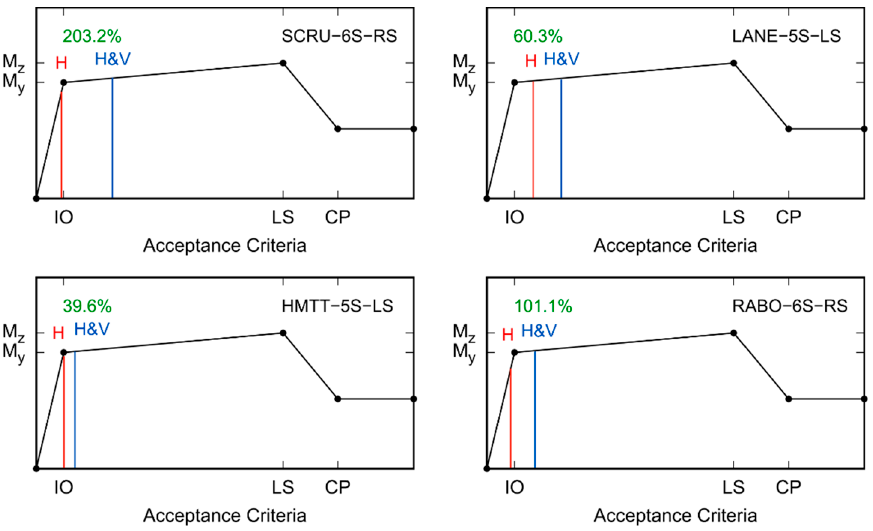
Figure 16. Examples of acceptance criteria for the 6-story building. Part 2.